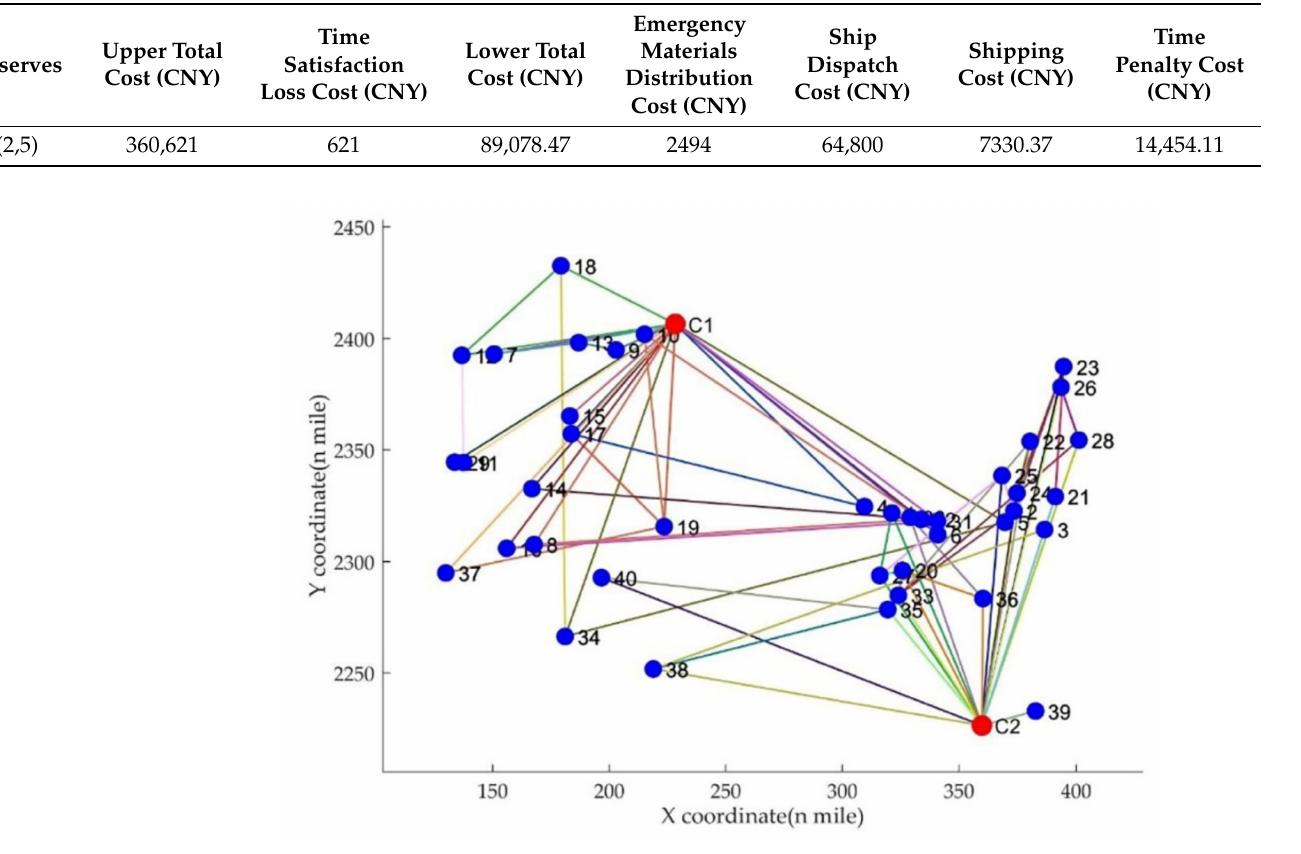
Figure 6. Location-routing